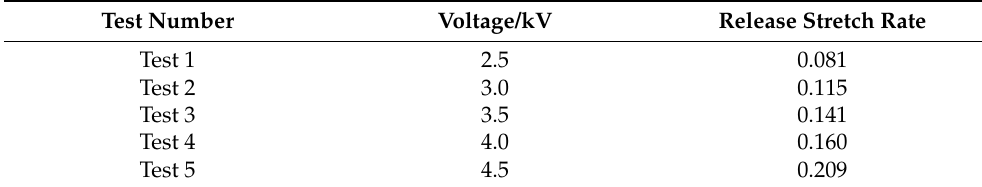
Table 6. Relationship between voltage and maximum release stretch